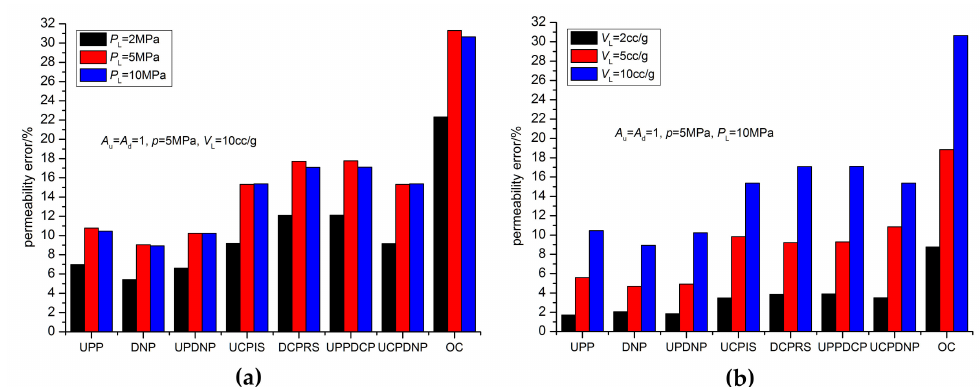
Figure 14. Permeability error caused by gas adsorption: ( a ) Langmuir pressure; ( b ) Langmuir